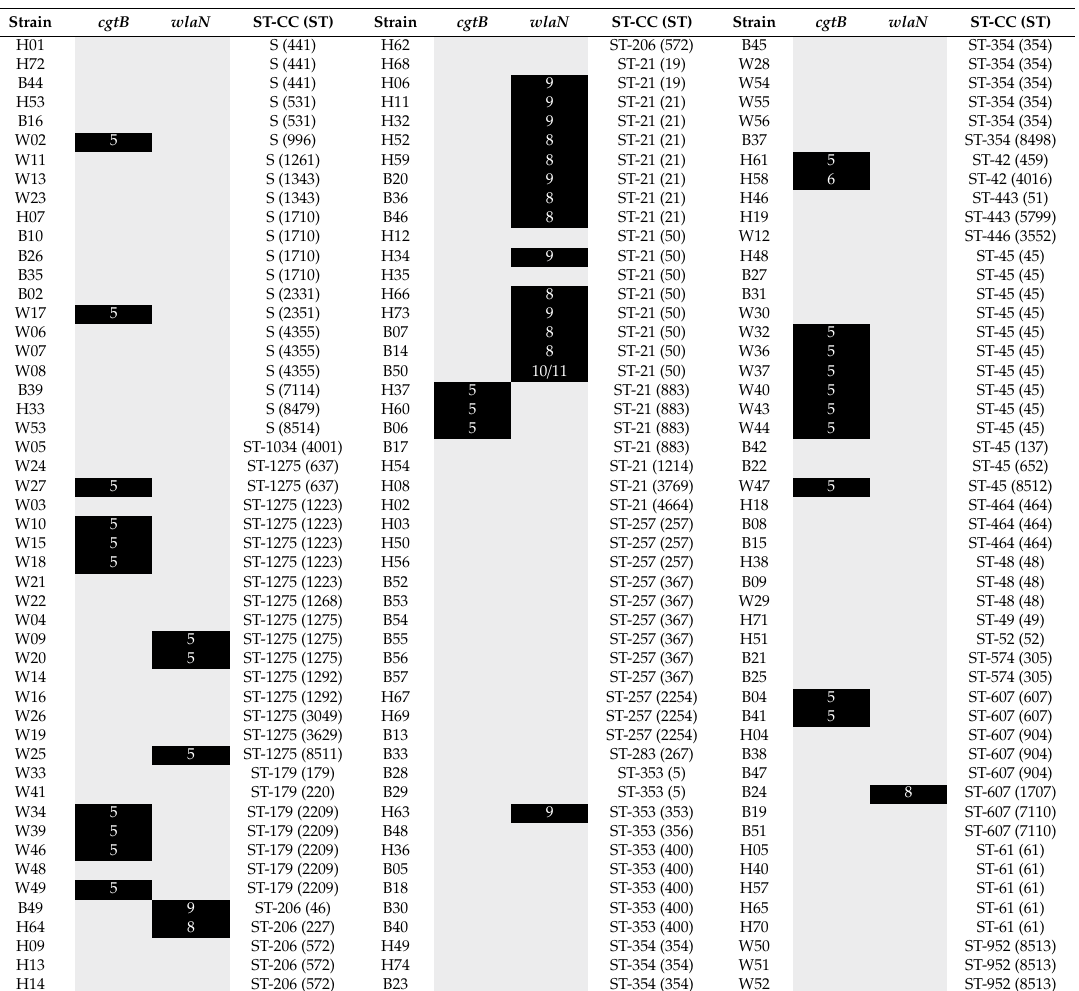
Table 2. Collection of C. jejuni isolated from human patients (H), broiler chikens (B), and wild birds (W). Strains are organized attending to their ST Clonal Complexes (ST CC) and sequence types (ST). S means a singlenton ST. cgtB and wlaN positive strains are indicated (black squares) and the number of G residues found in the G-tract is